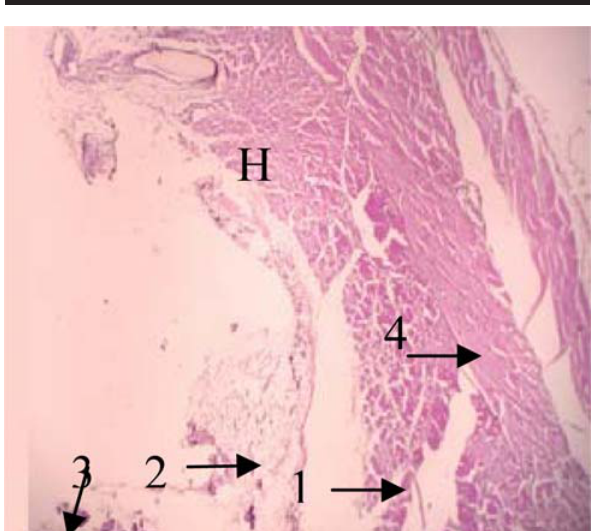
FIGURA 6 - Animal do grupo B - Cortes histológicos de fragmento de tecido constituído por musculatura estriada esquelética (1) e tecido fibroadiposo (2) com vasos ectasiados e granulomas do tipo corpo estranho em torno de fio de sutura e (H) com focos de poucos infiltrados inflamatórios (3) parede do canal inguinal (4). Corado por H. E.